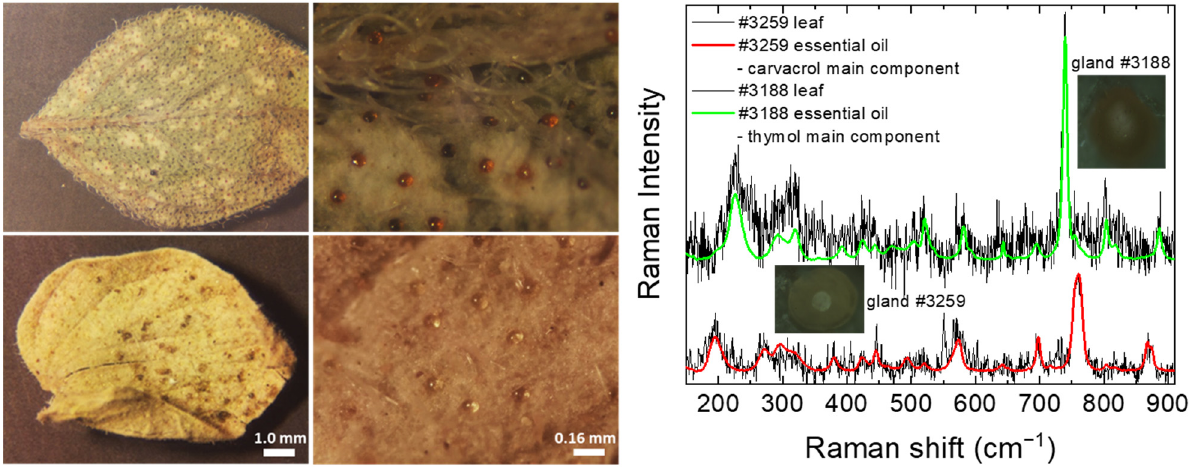
Figure 5. ( Left ) Photomicrographs of leaves from two taxa of the genus Origanum : ( top ) #3188, O. vulgare subsp. hirtum (lower leaf surface) and ( bottom ) #3259, O. onites (upper leaf surface). Scales are common for the images in the same column. The typical diameter of the glands is ~80 μ m. ( Right ) Raman spectra (100–900 cm − 1 ) from glands of the illustrated leaves, after subtraction of spectra from the edge of the glands, and their respective EOs’ spectra.